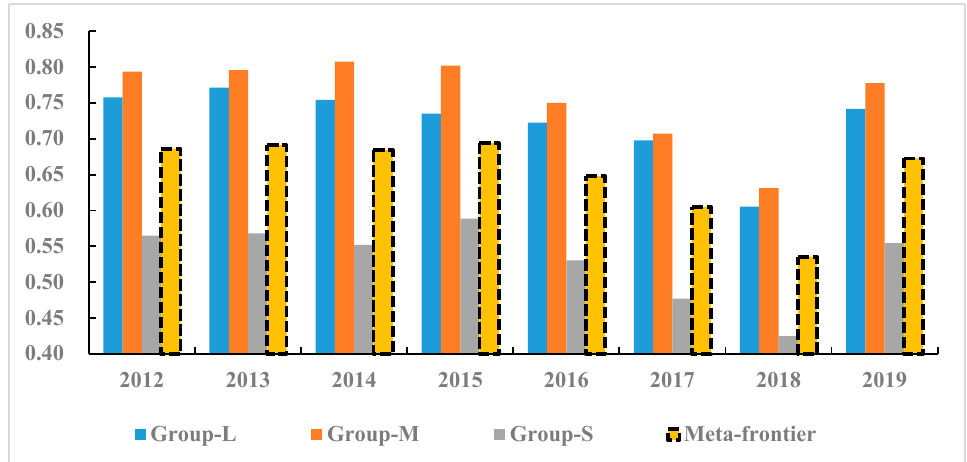
Figure 3. Time series changes in energy efficiency of the different groups during the period of 2012–2019.